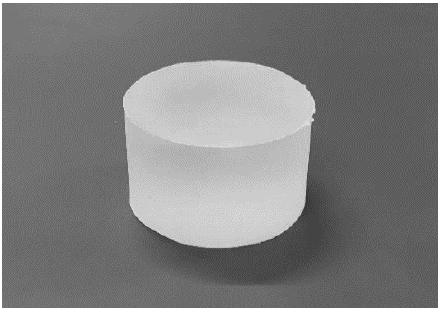
Figure 1. Test piece created from thermoplastic resin and paraffin oil.